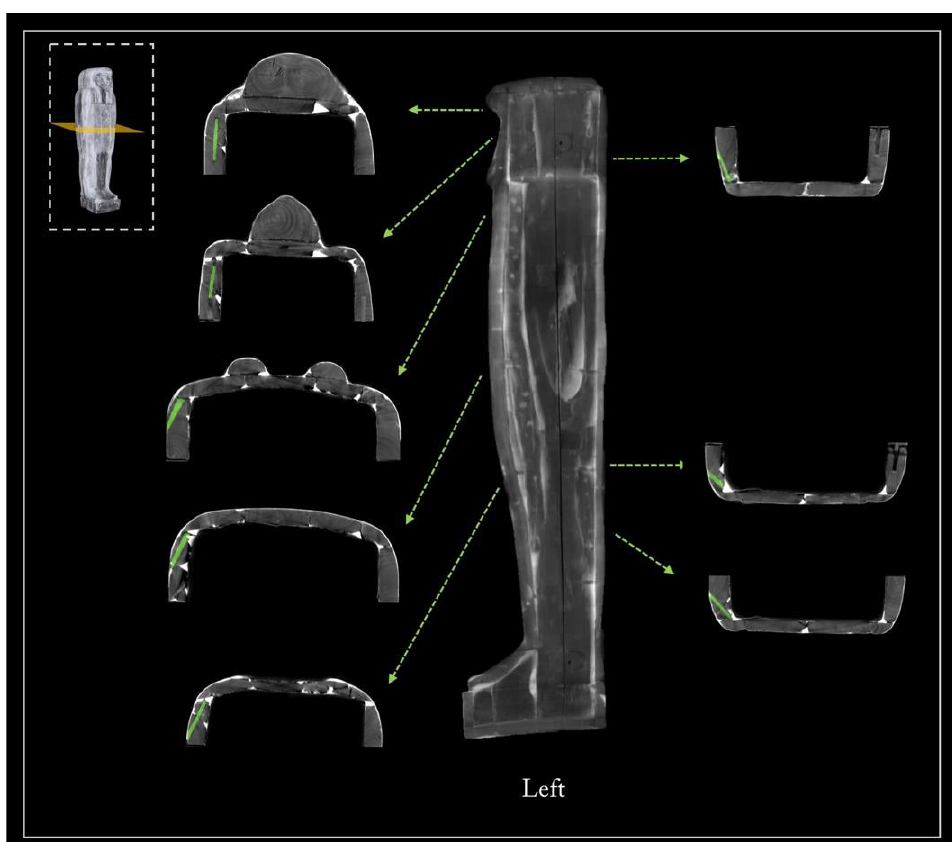
Figure 11. 3D rendering of the left side of the coffin, lid, and box. In green, the numerous dowels joining the planks.